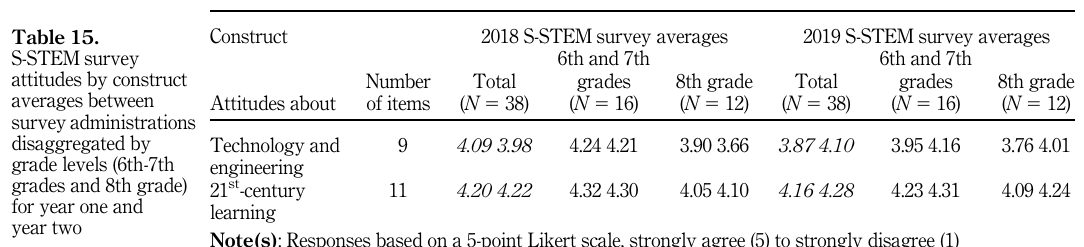
Table 14. S-STEM survey attitudes by construct averages between survey administrations disaggregated by race/ ethnicity (white and non-white) for year one and year